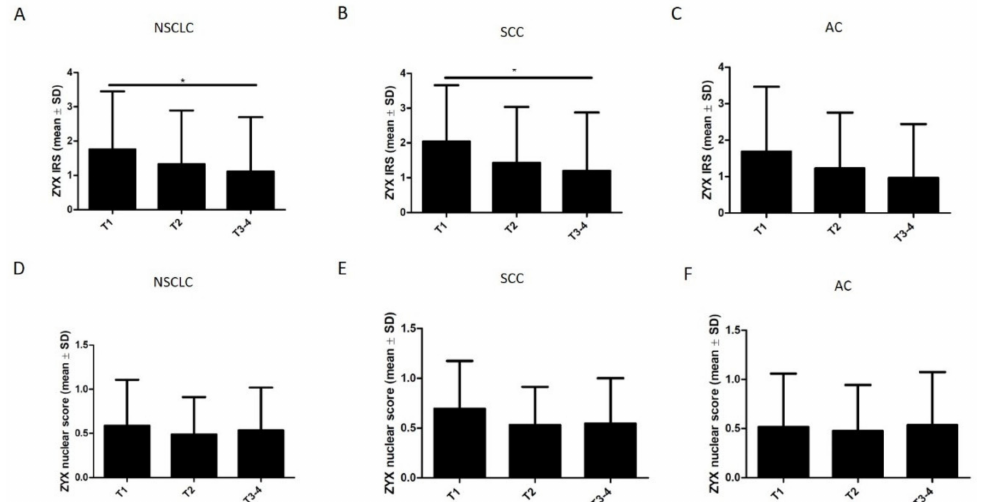
Figure 10. Immunohistochemistry (IRS, nuclear score) of ZYX expression in NSCLC cells in relation to tumor size (pT). Results for NSCLC ( A , D ), SCC ( B , E ), and AC ( C , F ) subtypes. Dunn’s multiple comparisons test (* p <